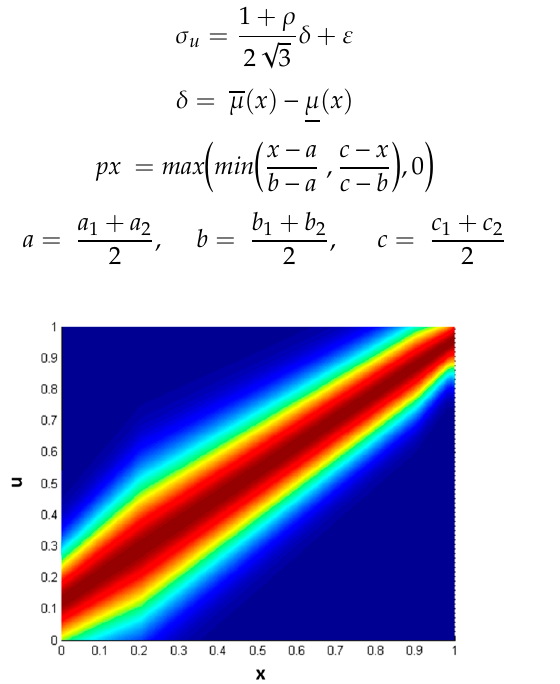
Figure 3. Generalized membership function trigausstype-2.